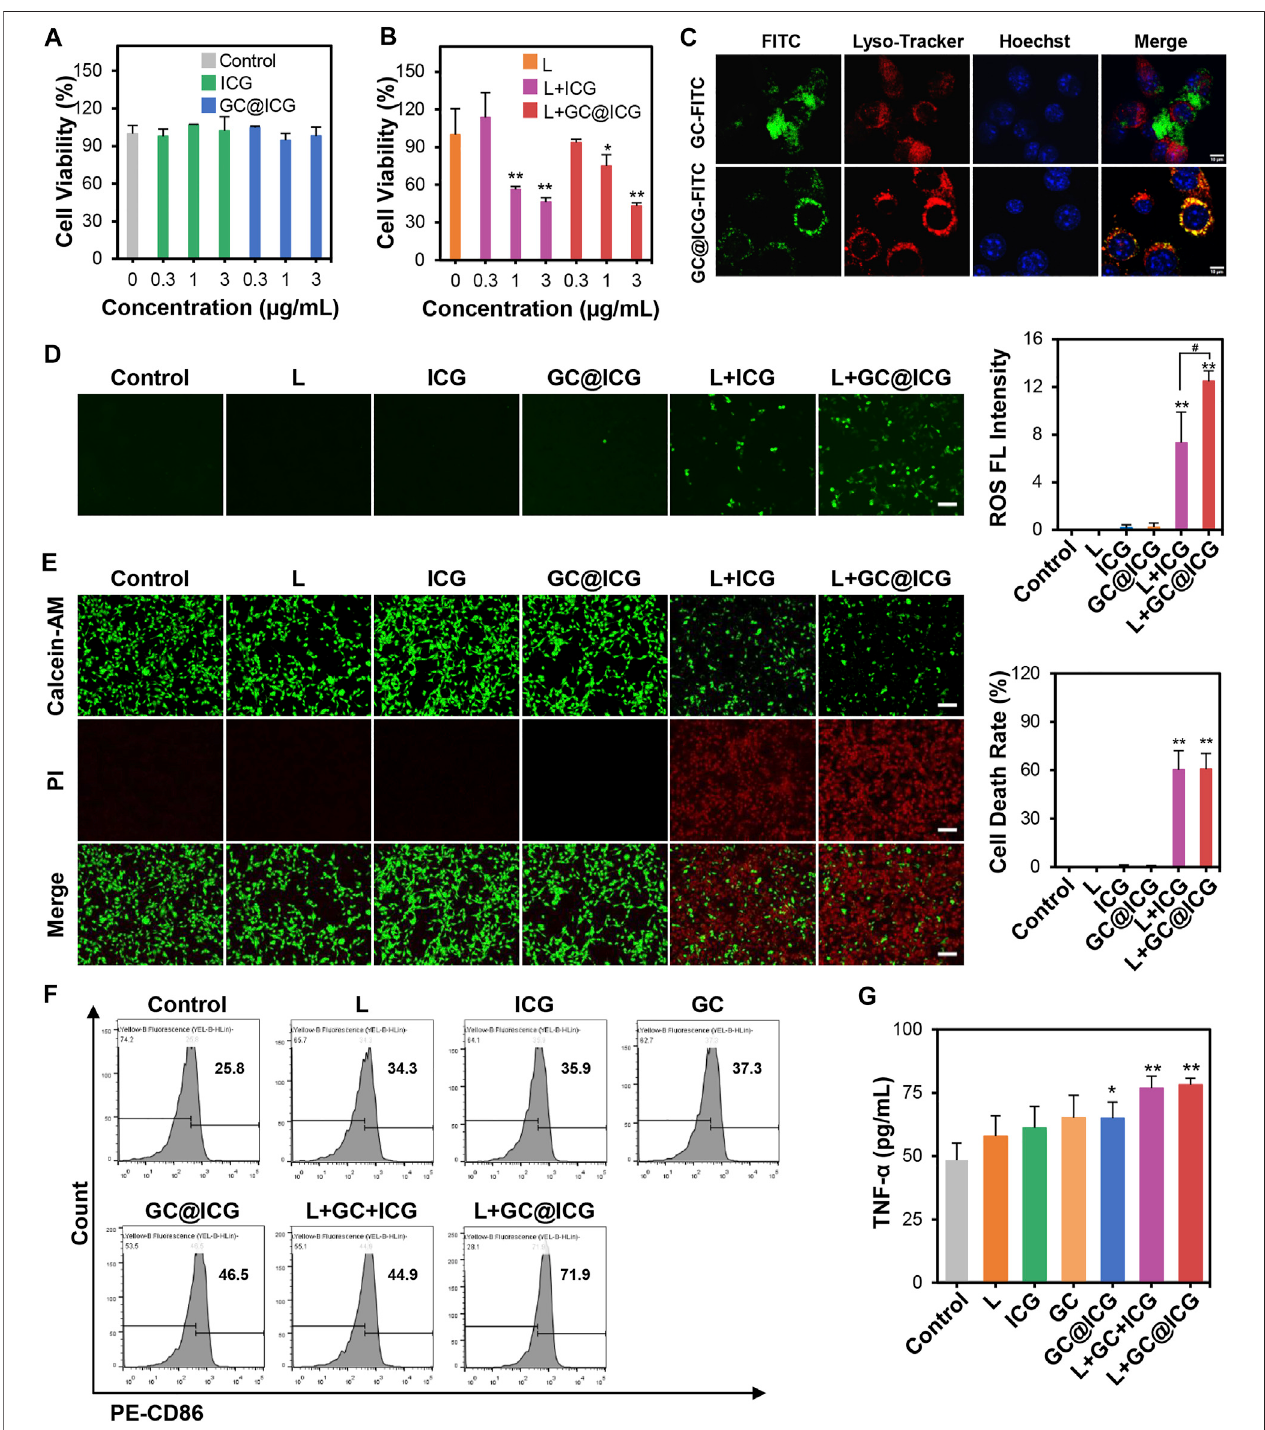
FIGURE3| ImmunogenictumorcelldeathinducedbyGC@ICGNPsbasedphototherapy.Cellviabilityof4T1cellsafter incubationwithdifferentconcentrationsof ICG (0.3, 1, and 3 μ g/ml) without (A) or with (B) 808 nm at 0.8 W/cm 2 for 5 min ( n =3, p p < 0.05, pp p < 0.01). (C) Fluorescence images ofintracellular localization ofGC and GC@ICG in 4T1 cells. Scale bar: 10 μ m. (D) Fluorescence images of ROS production in 4T1 cells stained with DCFH-DA (a ROS probe, green). Scale bar: 100 μ m. Bar graph demonstrated ROS fl uorescence intensity ( n = 3, pp p < 0.01 and # p < 0.05 vs. indicated groups). (E) Fluorescence images of 4T1 cells stained with calcein-AM/PI for cell death evaluation after different treatments. Live cells: green, calcein-AM. Dead cells: red, PI. Scale bar: 100 μ m. Bar graph demonstrated percentage of cell death rate ( n = 3, pp p < 0.01). (F) Flow cytometric analysis of CD86 expression on the surface of DCs with different treatments. (G) ELISA analysis of TNF- α released from DCs stimulated by GC and GC@ICG ( n = 3, p p < 0.05, pp p < 0.01).